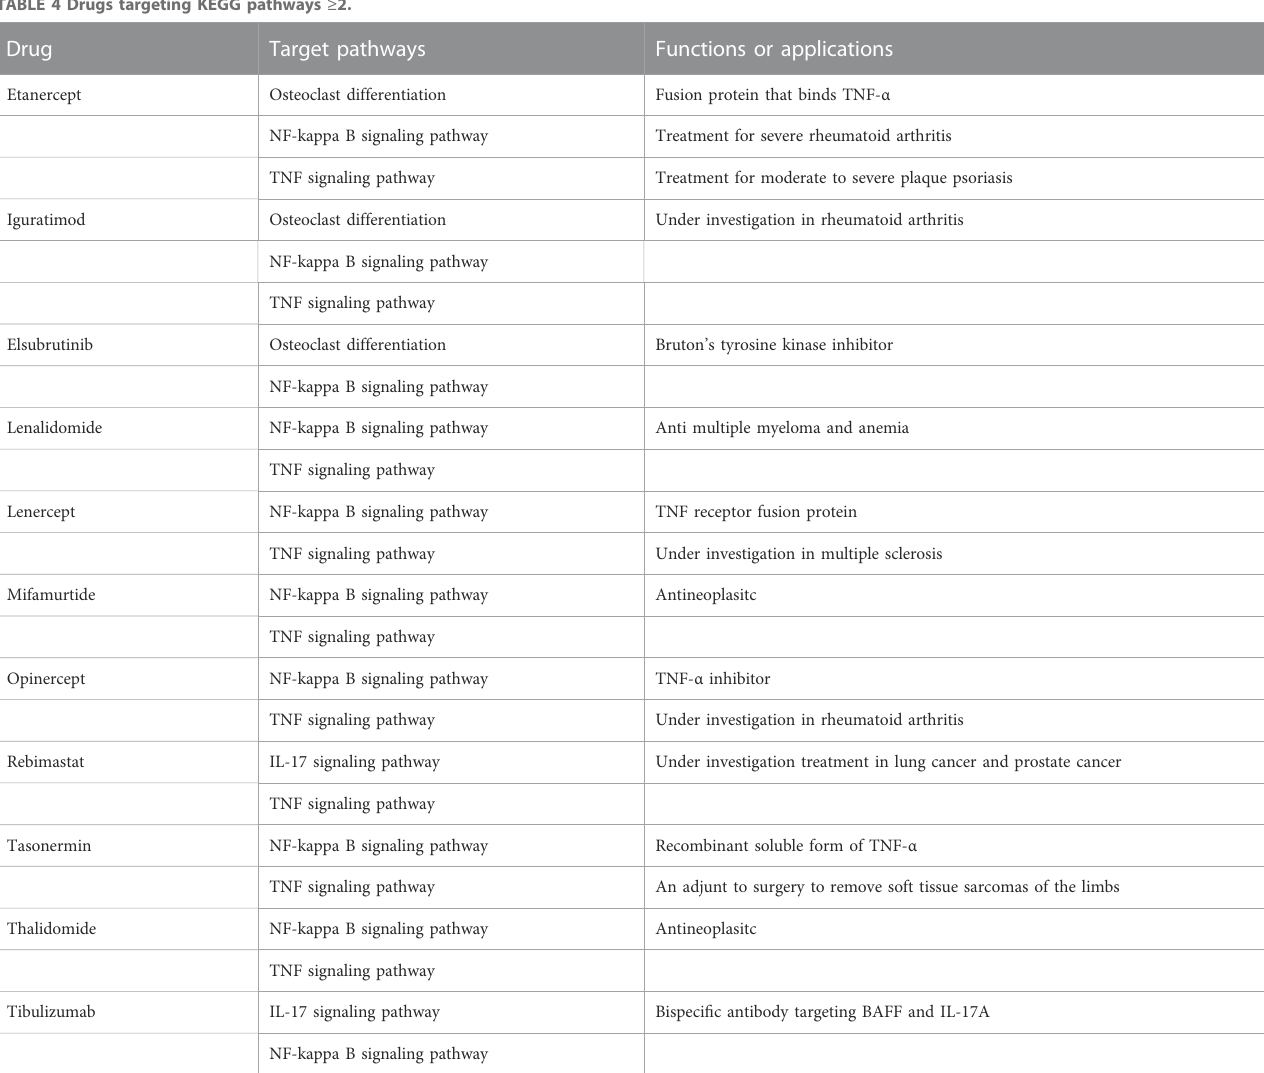
TABLE 4 Drugs targeting KEGG pathways ≥